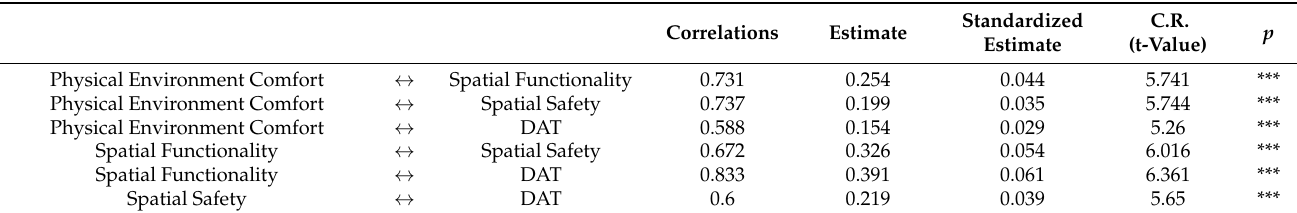
Table 5. Correlation Analysis.